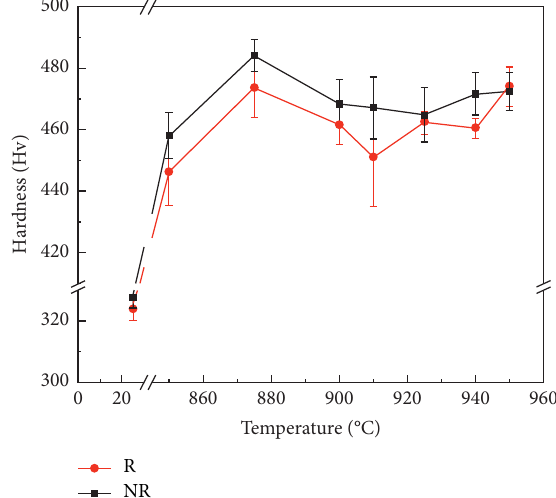
Figure 13: Vickers hardness in R and NR parts of specimens that underwnt RHT and